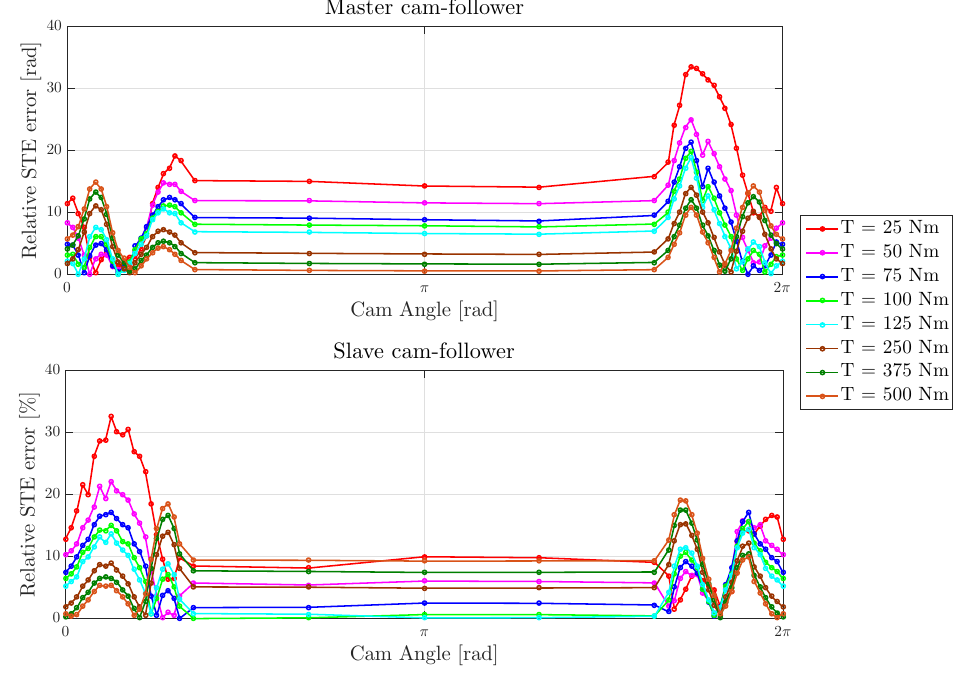
Figure 7. Absolute value of the relative STE error comparison of the Simscape LPM with respect to the FEM for both master ( top ) and slave ( bottom ) cam-follower subsystems at different torque